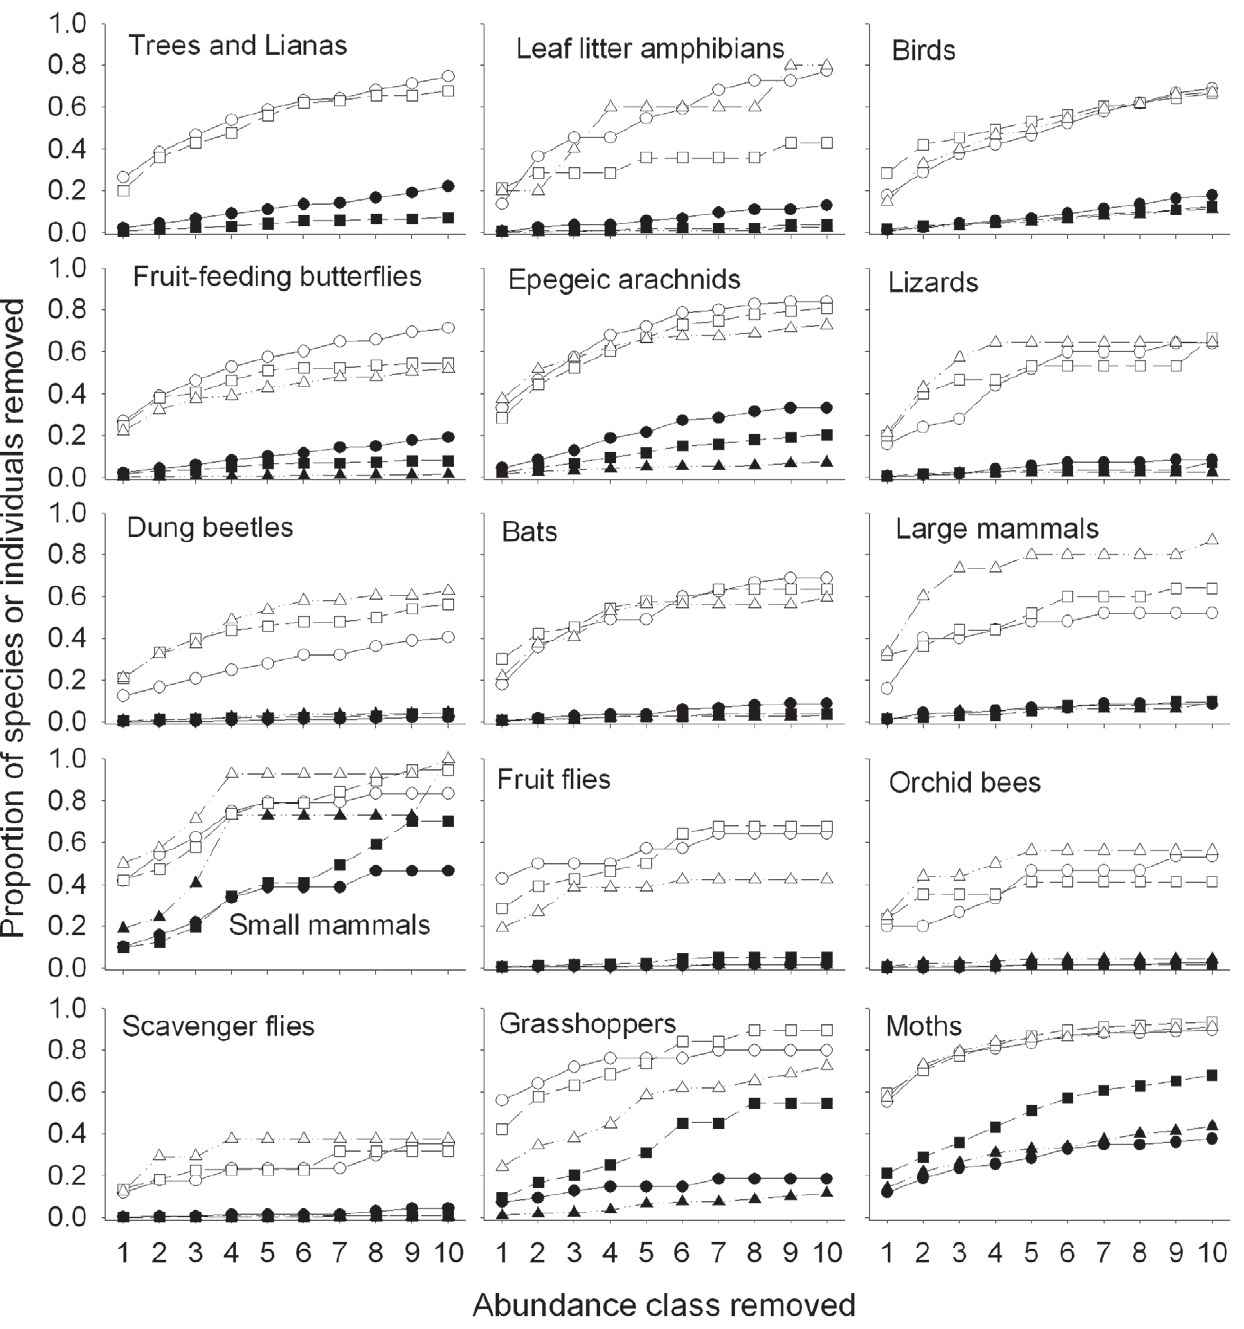
Figure 3. Patterns of rarity in the species data used in this paper. Panels show the cumulative proportion of species (black symbols) and individuals (open symbols) removed from primary forest (circles), secondary forests (squares) and tree plantations (triangles) (i.e. following the removal of singletons, doubletons, and so on, up to those species that were recorded # 10 times in each forest type).